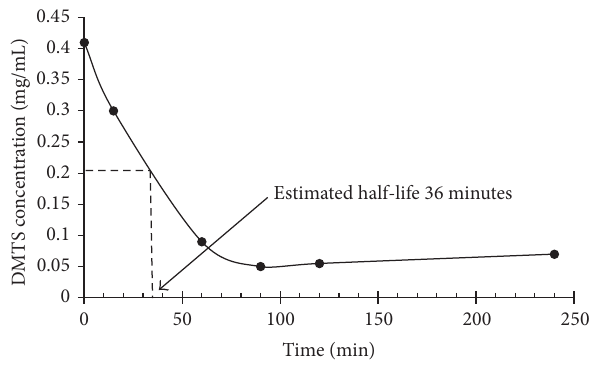
Figure 4: Half-life determination for DMTS-Poly80 graphically from the plotted DMTS concentrations in blood versus sampling times after intravenous injection of DMTS-Poly80 in rat